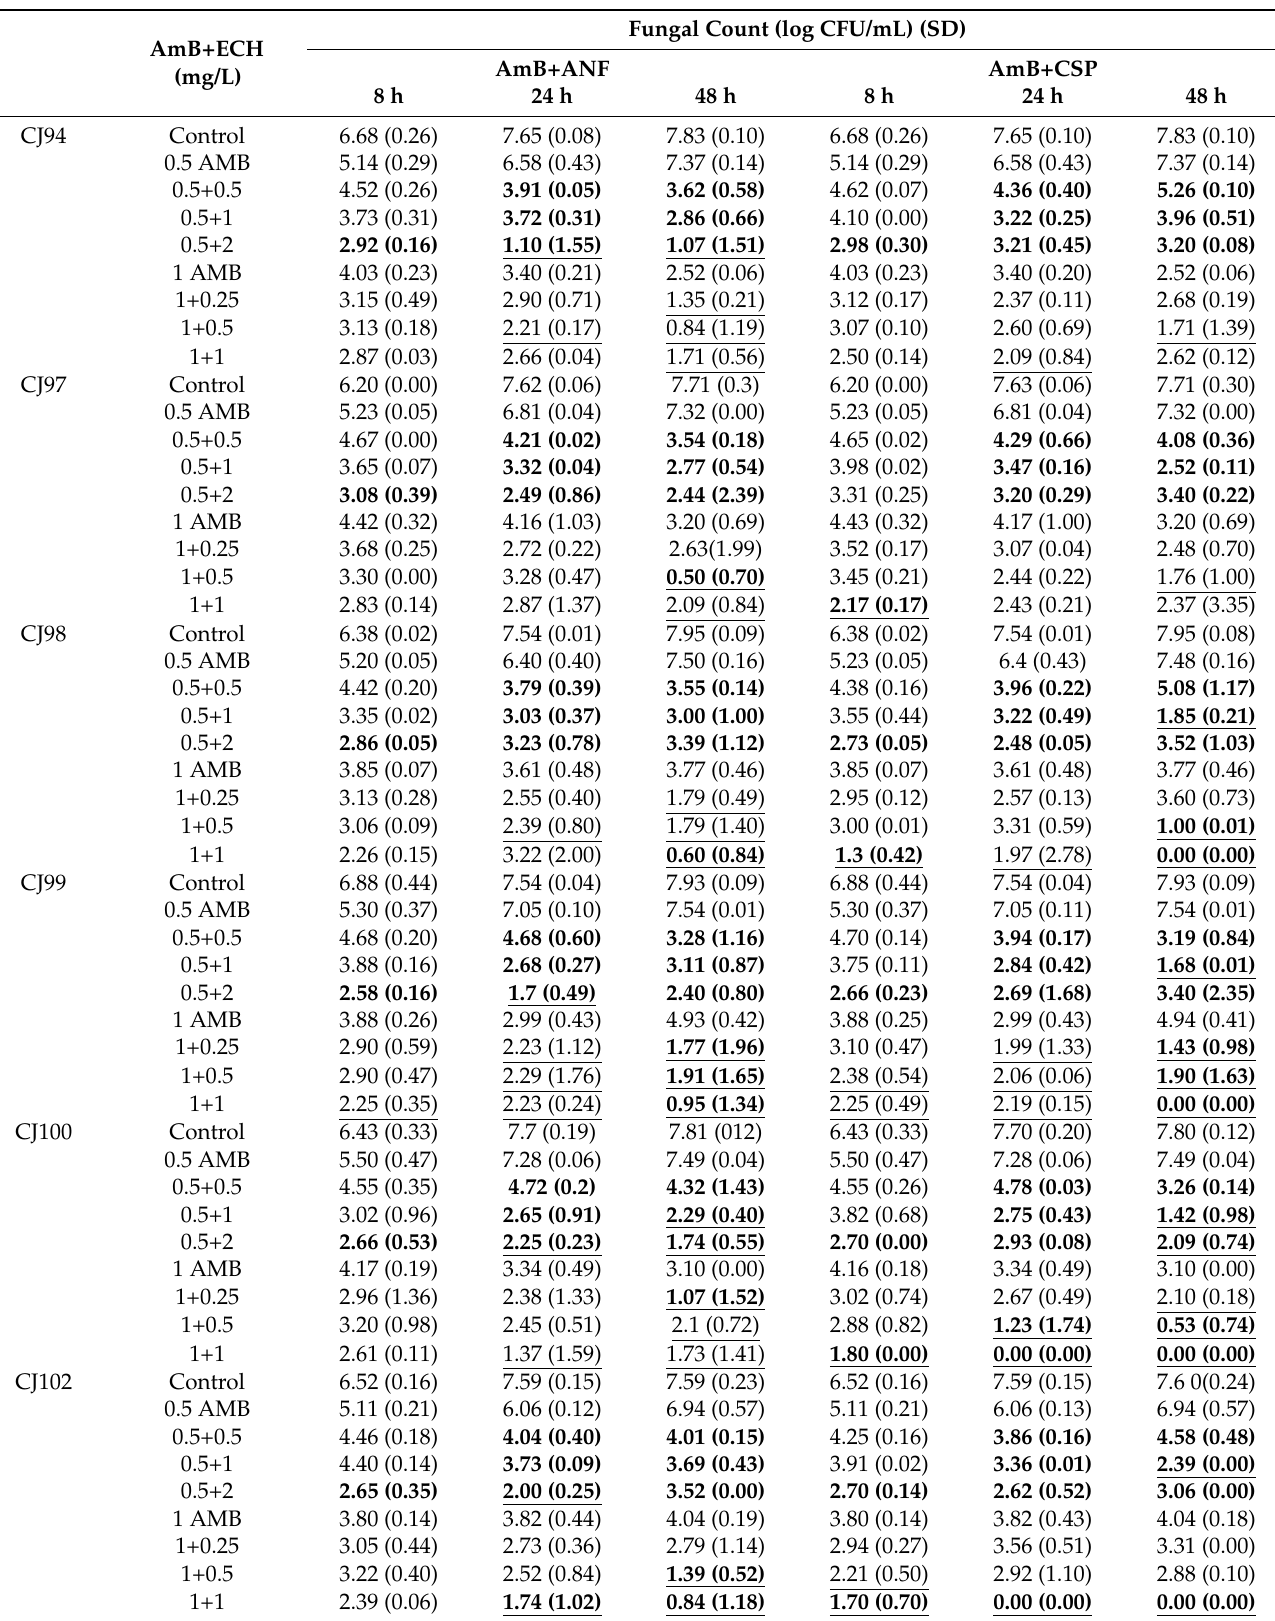
Table 1. Fungal counts at 8, 24, and 48 h and interaction